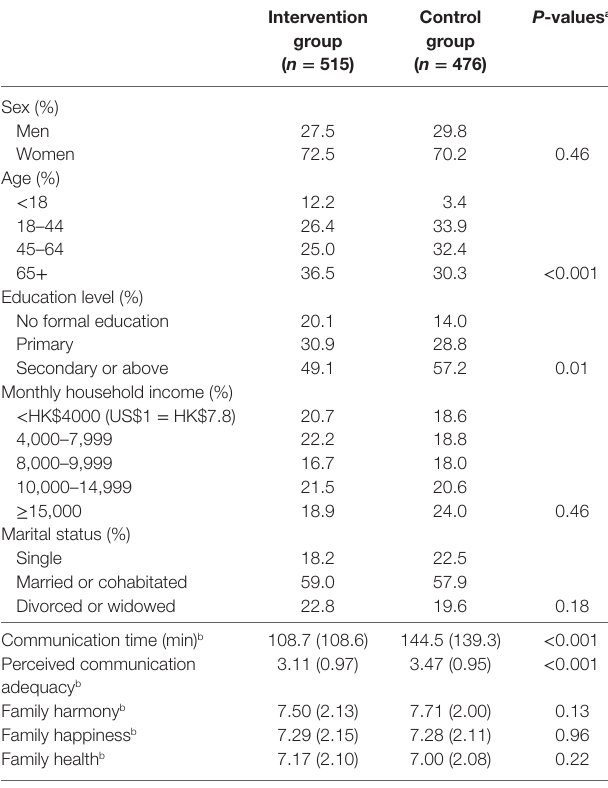
TaBle 1 | Baseline demographic characteristics, mediators, and outcomes between participants in the intervention and control